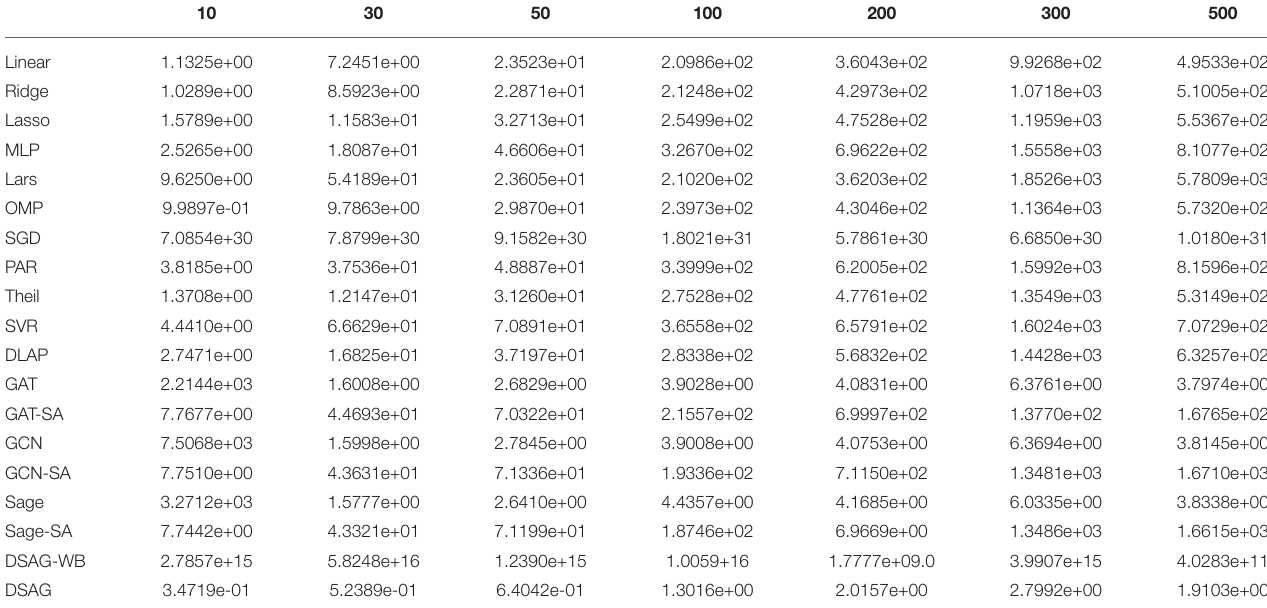
TABLE 2 | Performance comparison on c499.